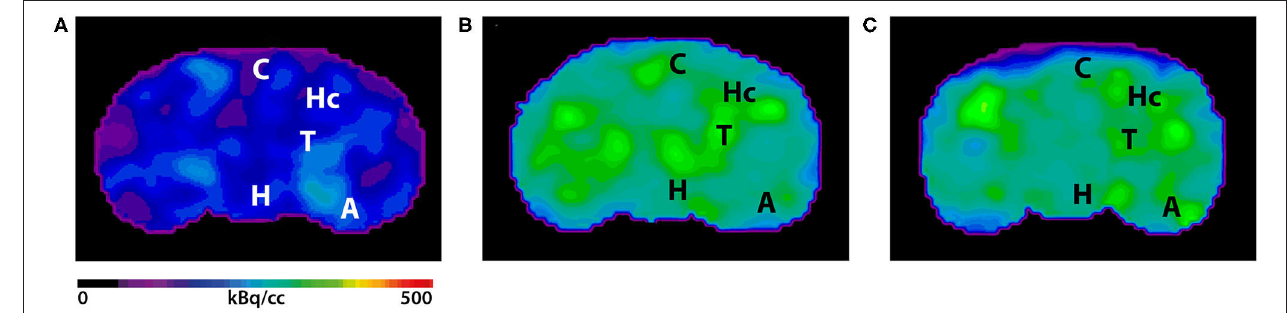
FIGURE 4 | 18 F-Florbetaben-PET images in coronal view. (A) 18 F-Florbetaben image of a 7-month-old WT mouse. (B) Cerebral 18 F-Florbetaben uptake was higher in 7-month-old 5XFAD mice as well as in 12-month-old 5XFAD mice (C) . A, Amygdala; C, Cortex; H, Hypothalamus; Hc, Hippocampus; T,